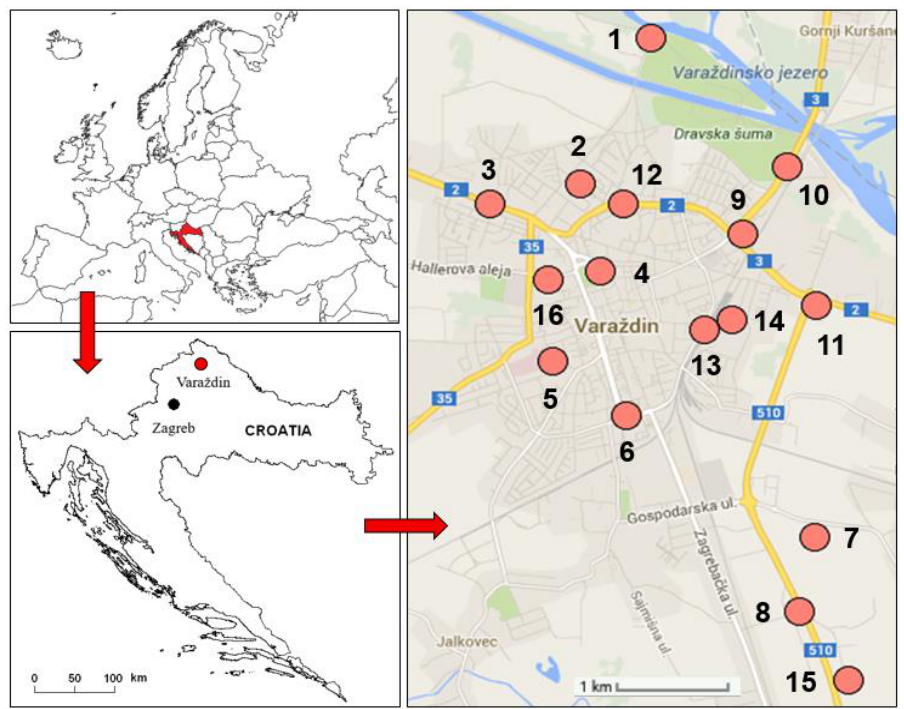
Figure 6. Study area of the city of Varaždin in northern Croatia with a posit ion of 16 sites.